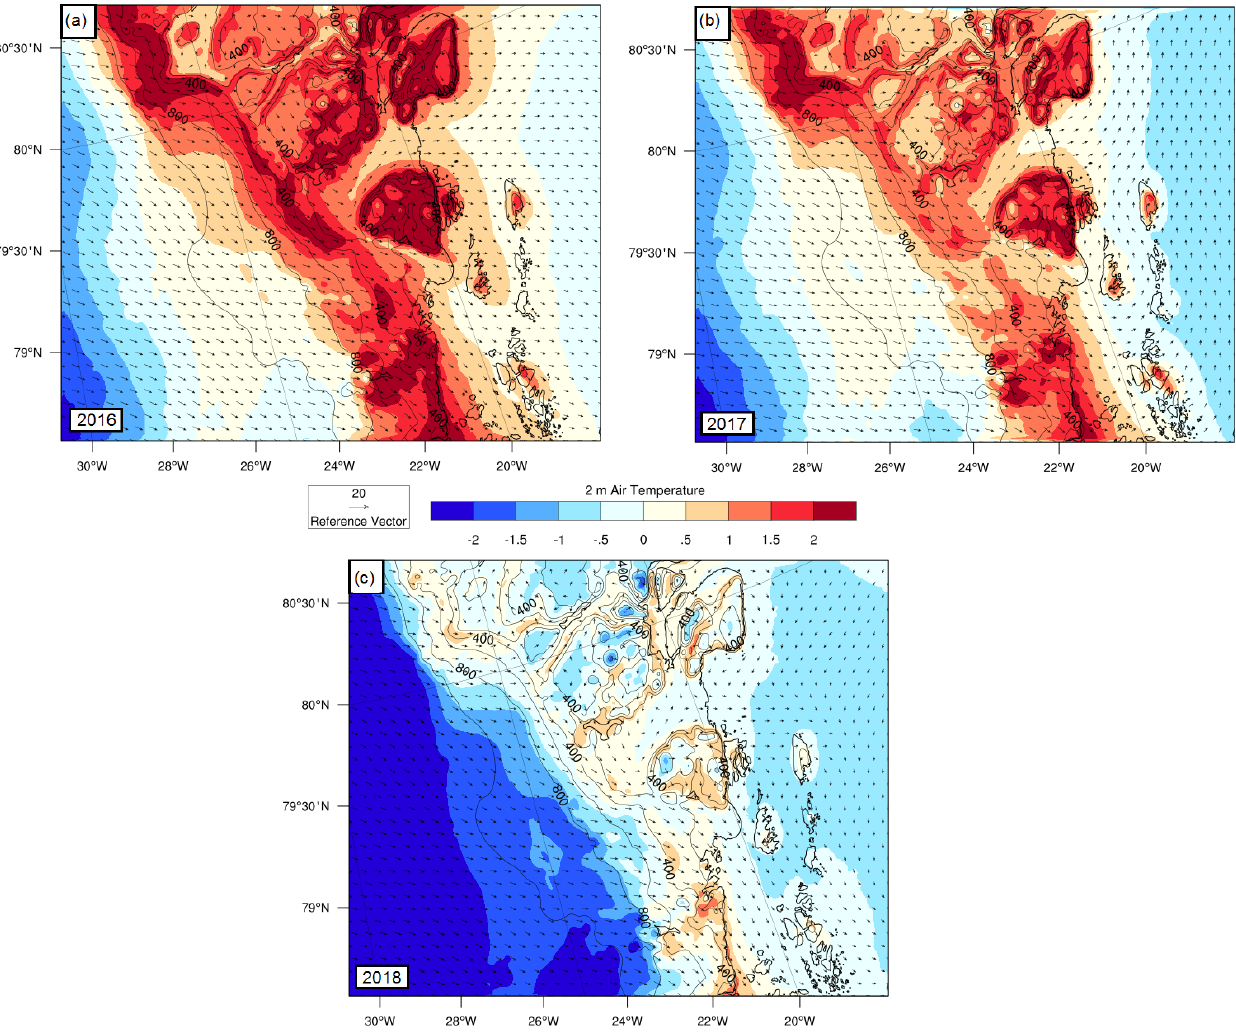
Figure 7. The monthly average 2m air temperature from PWRF runs for July 2016 (a) , 2017 (b) and 2018 (c) . Simulations were not available for 2019. Contours are every 200m, with labels every 400m. Black arrows are wind vectors, displaying monthly average wind direction and speed, with a reference vector of 20ms − 1